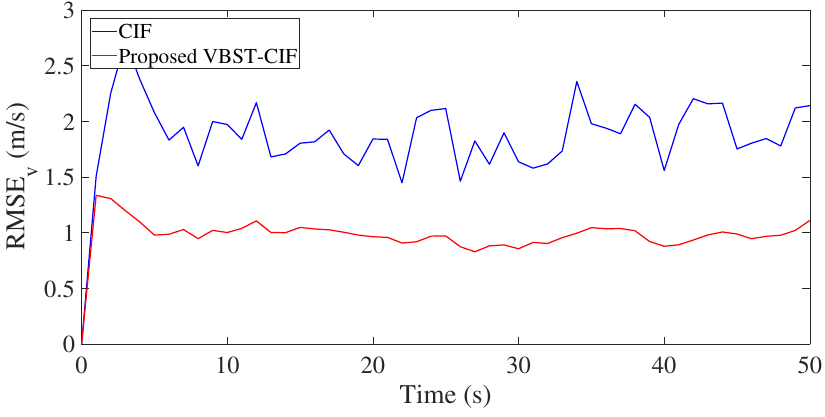
Figure 5. Velocity RMSE in single-sensor target tracking.